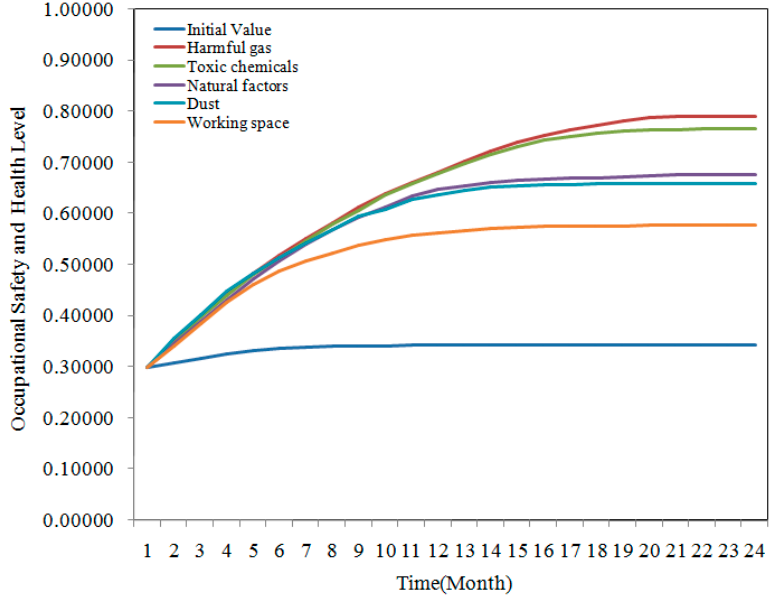
Figure 9. SD simulation of environment factor measures.